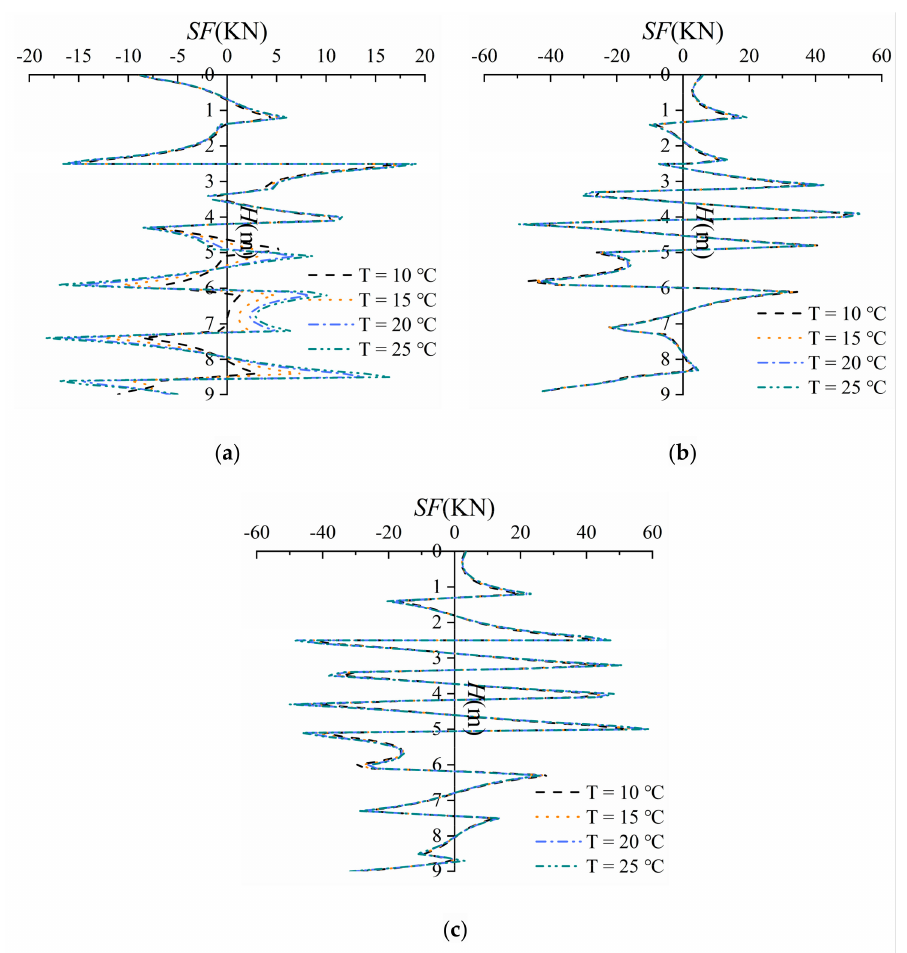
Figure 22. The shear force ( SF )–temperature relationship of ( a ) pile 1, ( b ) pile 2, and ( c ) pile 3. This equation confirms that the shear force on the retaining pile is within an allowable strength range of the